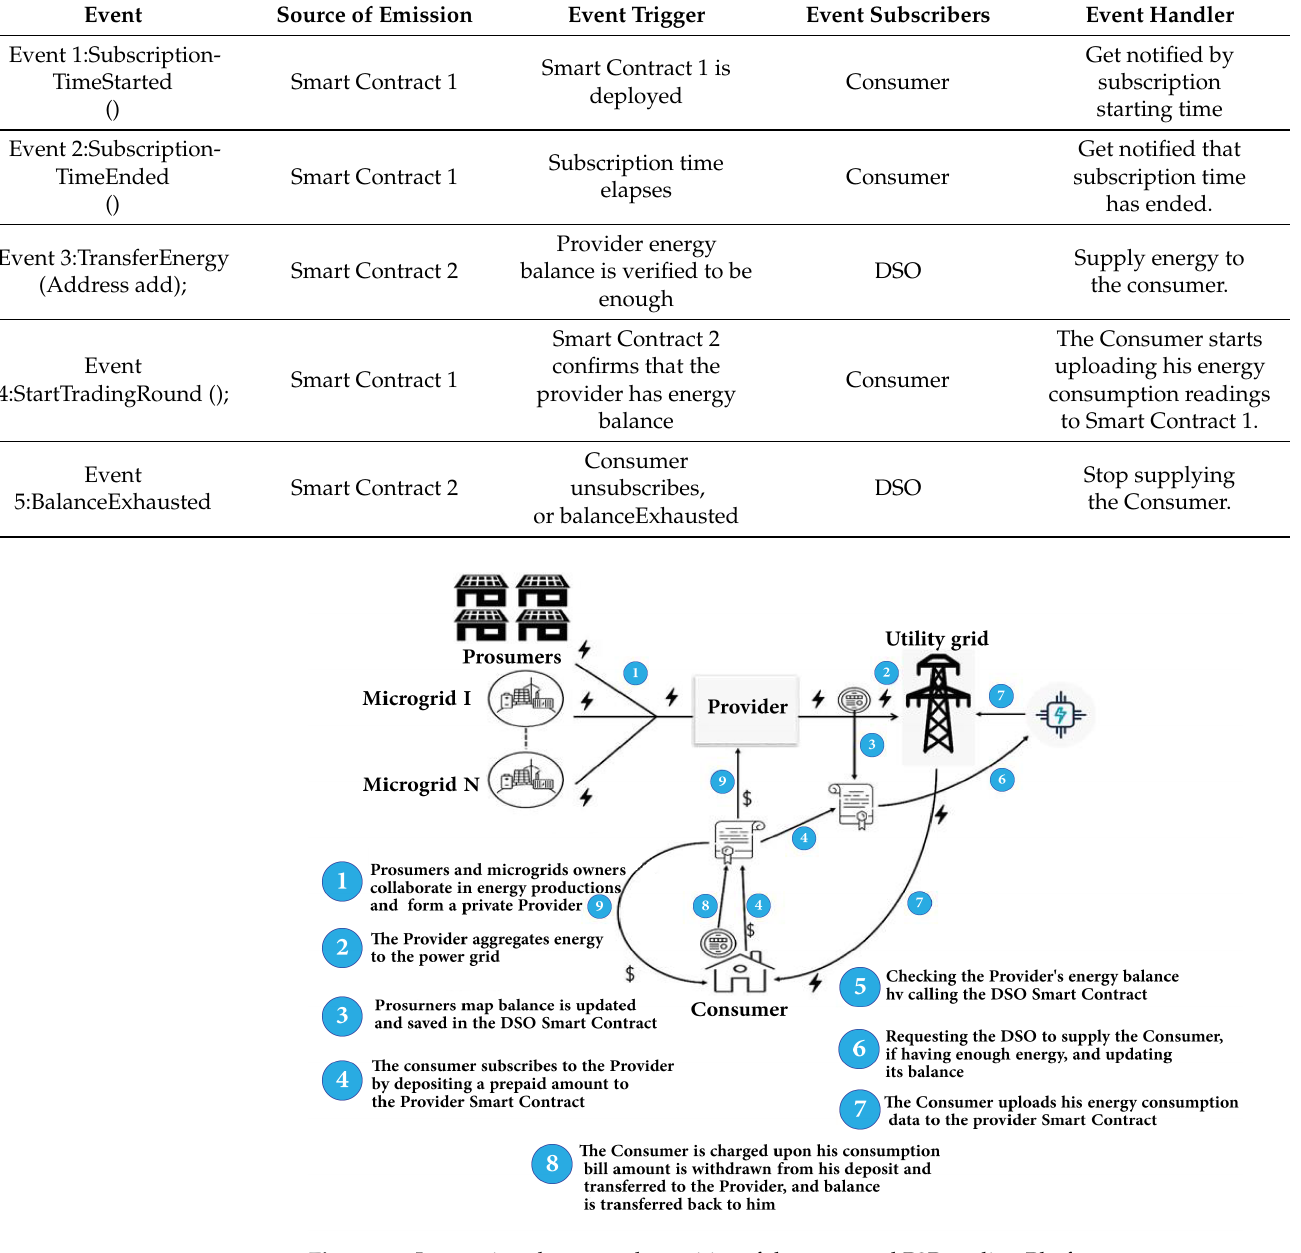
Table 2. Smart contracts’ events in the proposed platform.